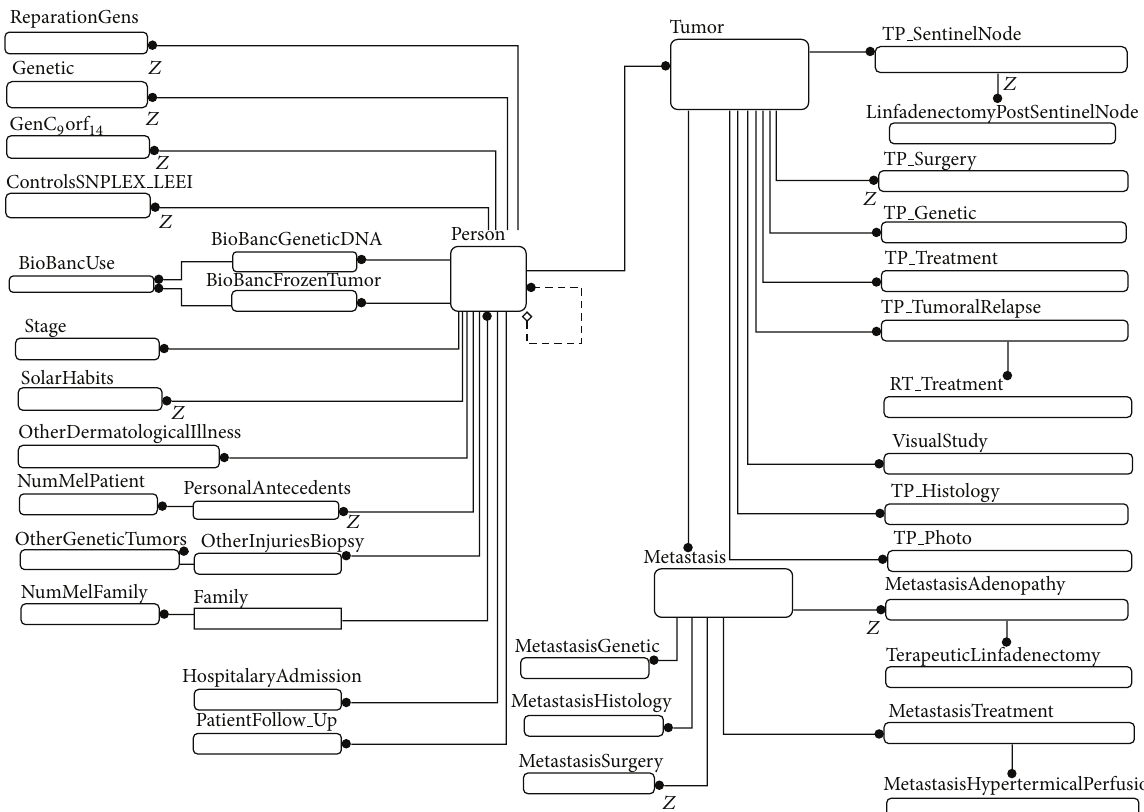
Figure 2: The melanoma relational model permits the definition of how to integrate data gathered from the different medical profiles. The model considers patient data, their family, generic information, tumors, metastasis, controls, and